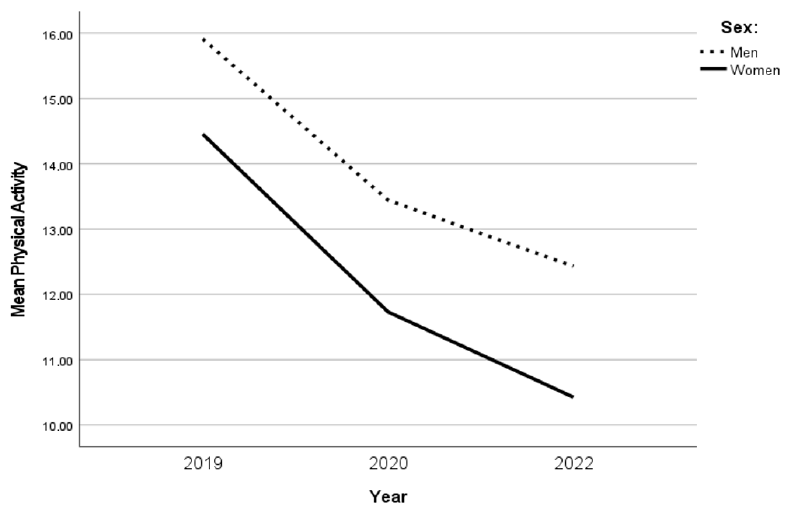
Figure 1. The changes in PA in sexes over time.